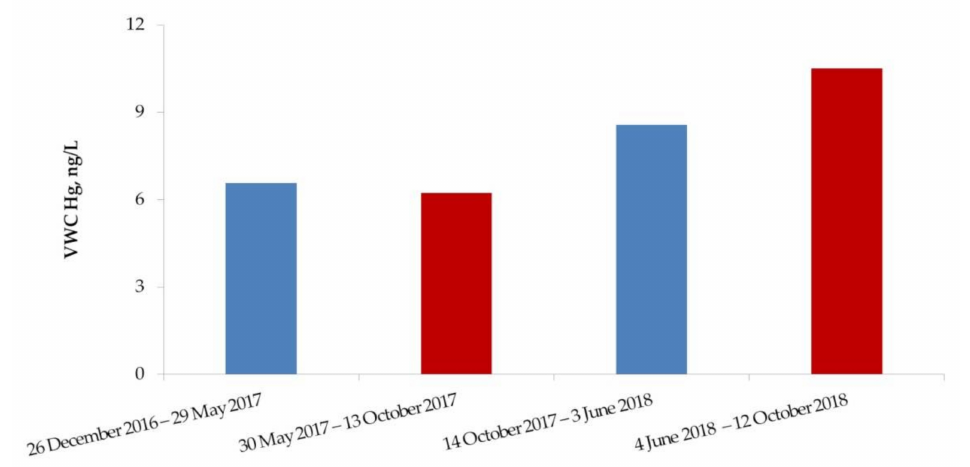
Figure 3. Seasonal volume-weighted concentrations of mercury (ng/L) in wet atmospheric precipita- tion in Nadym in the 2016–2018 years, red and blue colors correspond to warm and cold periods, respectively.